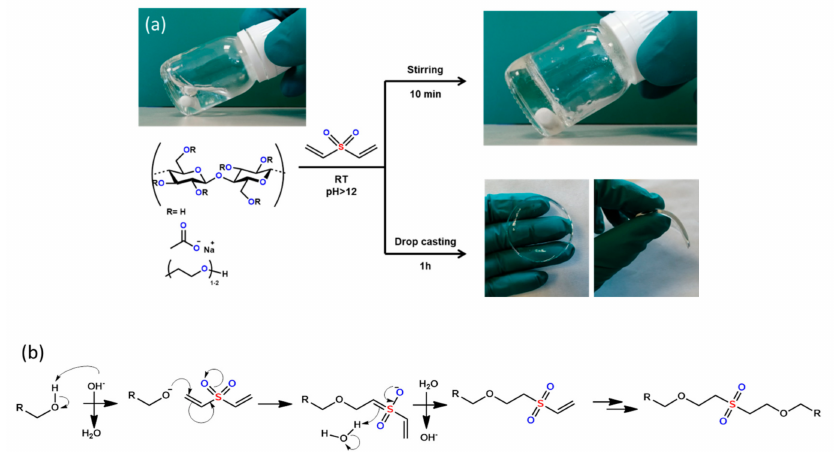
Figure 1. ( a ) Schematic representation of the synthesis of cellulose-based hydrogels ( b ) and crosslinking reaction